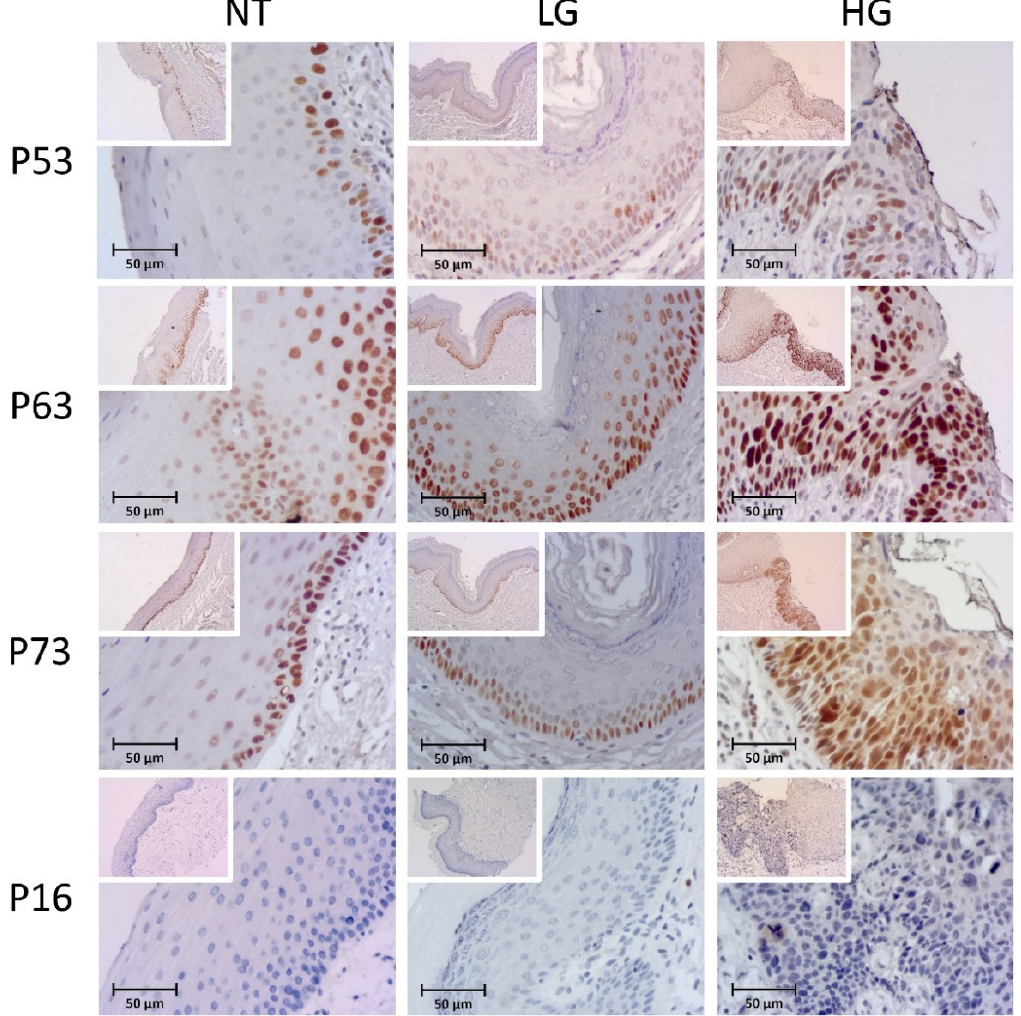
Figure 2. Immunohistochemical staining of the P53, P63, P73, and P16 proteins in normal tissues (NT), low-grade (LG), and high-grade (HG) cases. Small boxes inside the main photo (magnification ×200) correspond to the original image at magnification ×10. High expression can be observed for P53, P63, and P73 in HG, and for p63 in NT and LG cases.